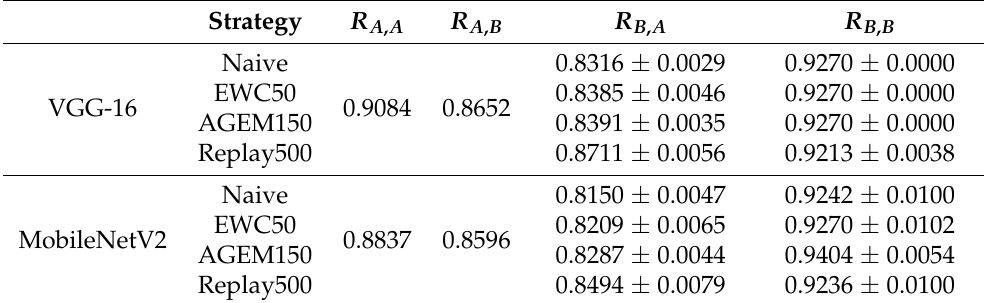
Table 5. Test results in terms of accuracy concerning the best approaches for the two models. Results averaged over 10 iterations ( ±